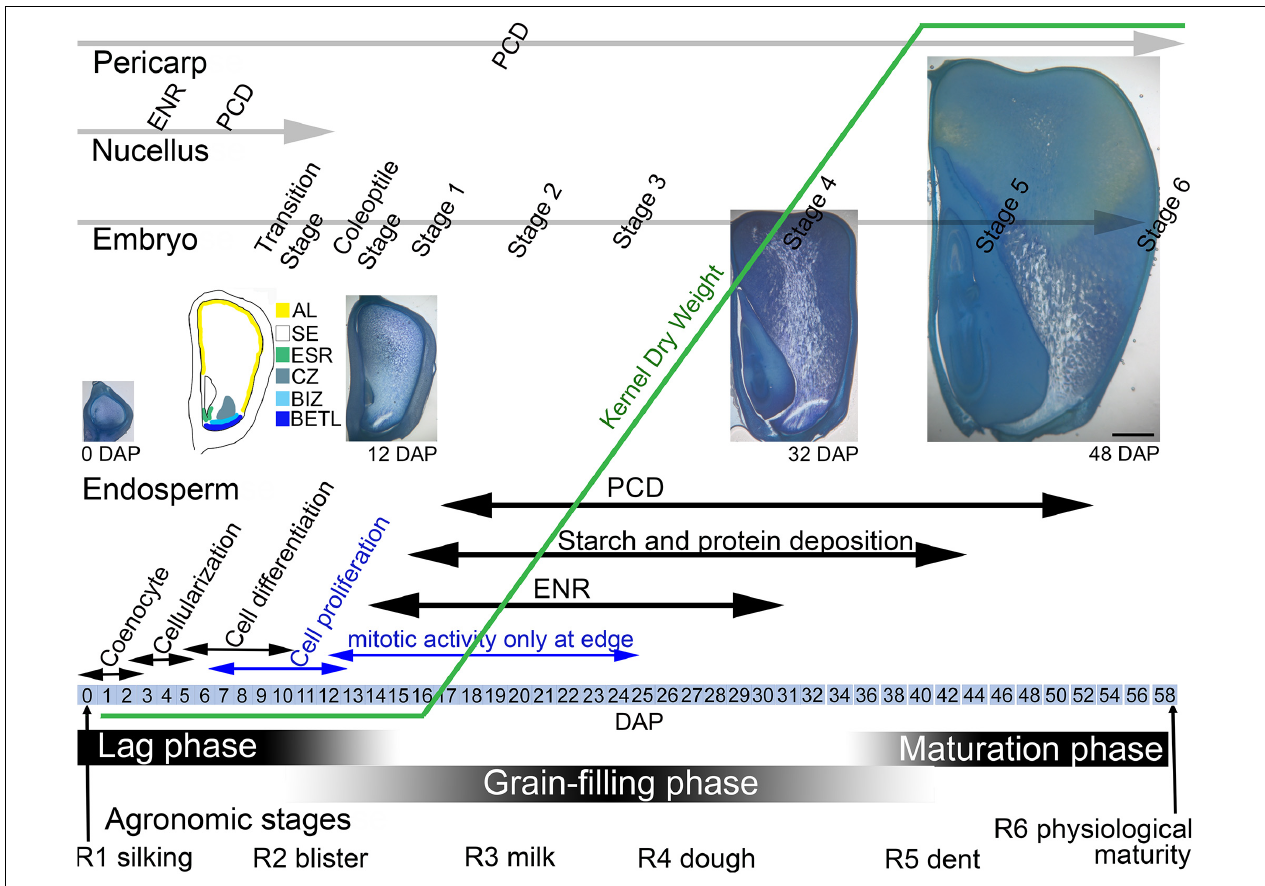
FIGURE 1 | Maize kernel development from pollination to maturity highlighting endosperm growth and development in concert with phases of seed development and development of the embryo. AL, aleurone; BETL, basal endosperm transfer layer; BIZ, basal intermediate zone; CZ, conducting zone; DAP, days after pollination; ENR, endoreduplication; ESR, embryo surrounding region; PC, placenta-chalazal region; PCD, programed cell death; SA, subaleurone; SE, starchy